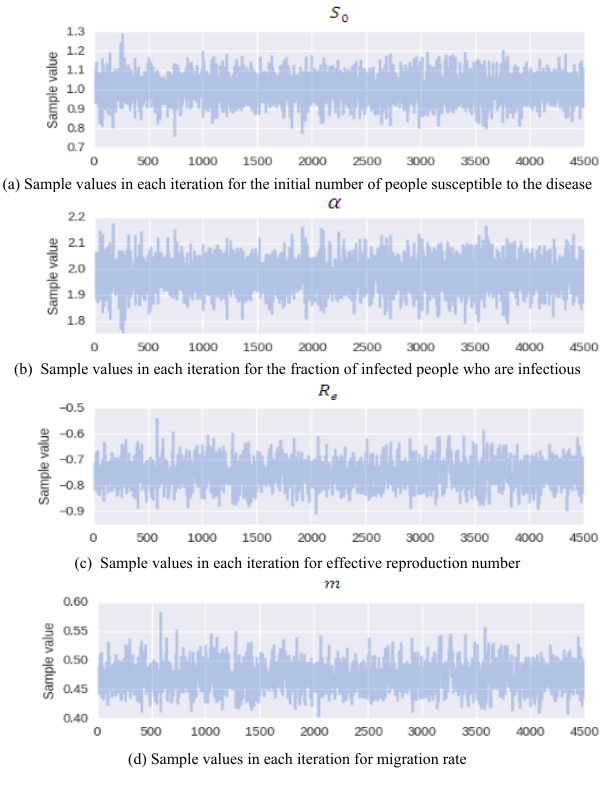
Figure 1. Comparison of the Number of Susceptible People (the Monte Carlo Simulation Model and the SIR Model). Figure 2 . Trace Diagrams of Simulated Model